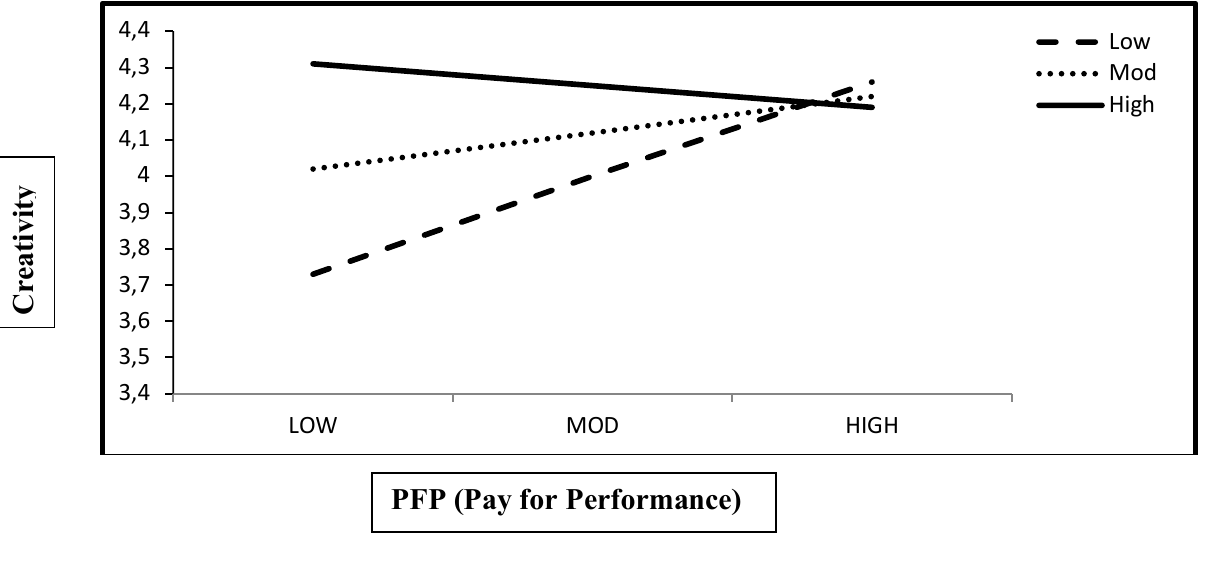
Figure 1: The Moderating